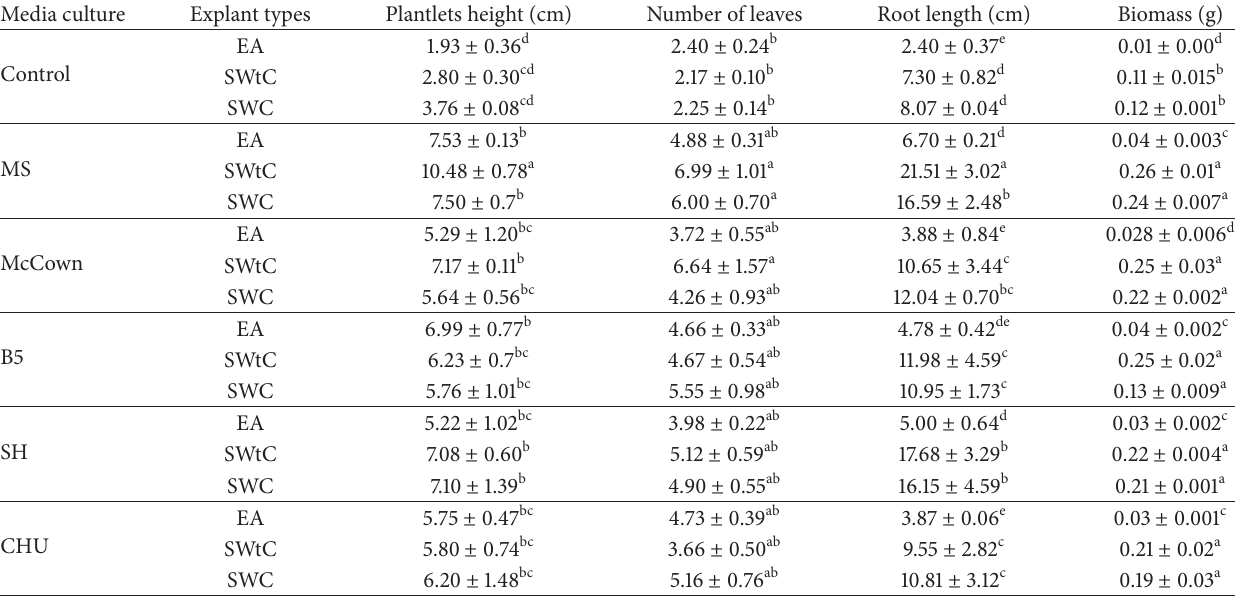
Table 1: Growth performance of Bambara groundnut in vitro plantlets derived from three explant types on different basal media after four weeks of